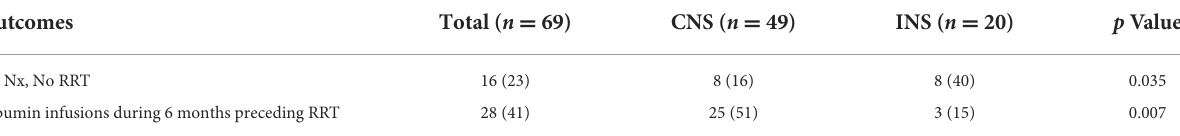
TABLE 5B Albumin infusions in children with CNS and INS.